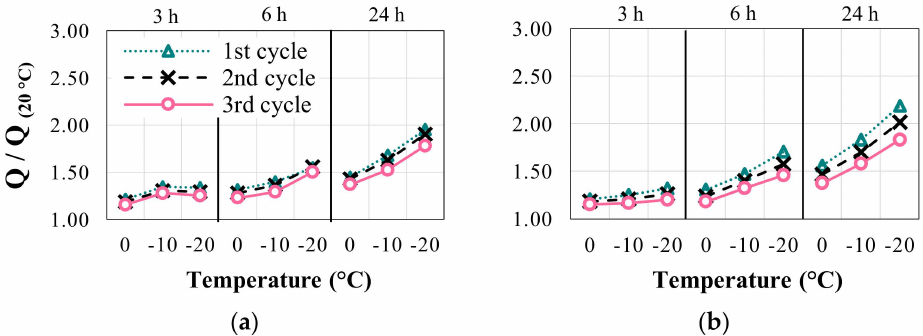
Figure 10. Comparison of normalized characteristic strengths for 0.1 Hz loading frequency at ( a ) 100% and ( b ) 134% shear strains.